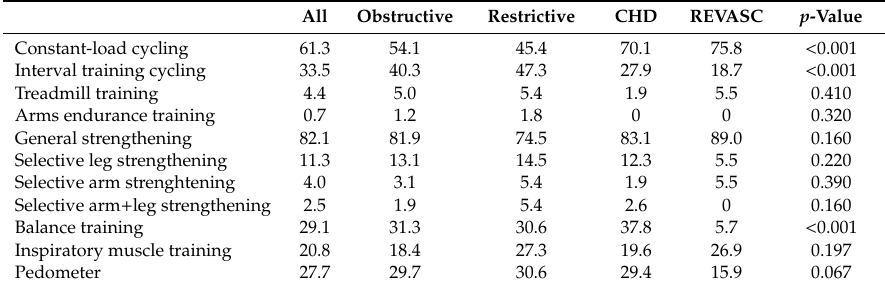
Table 3. Rate of prescription of program components by diagnosis group. All Obstructive Restrictive CHD REVASC p -Value Constant-load